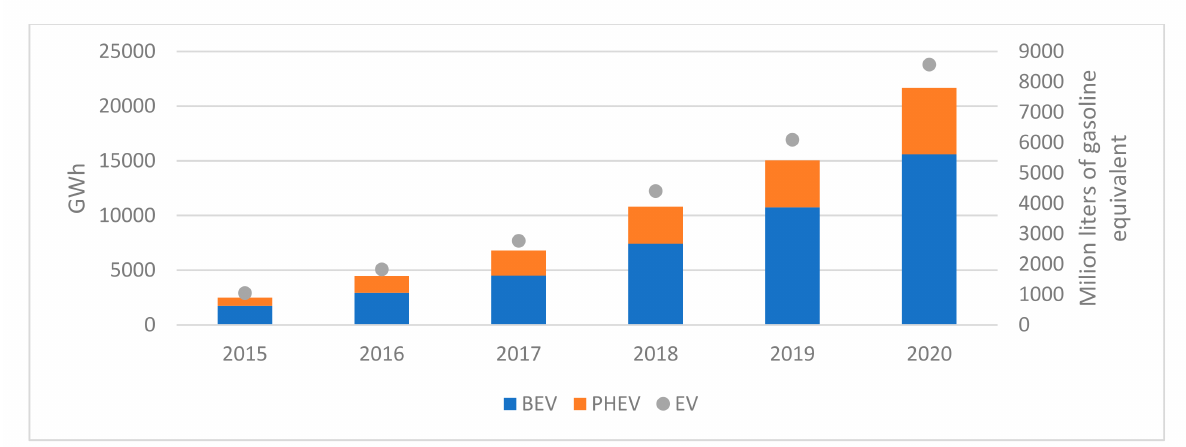
Figure 6. Electricity demand vs. oil displacement among cars, worldwide between 2015 and 2020. Source: https://www.iea. org/articles/global-ev-data-explorer (accessed on 10 October